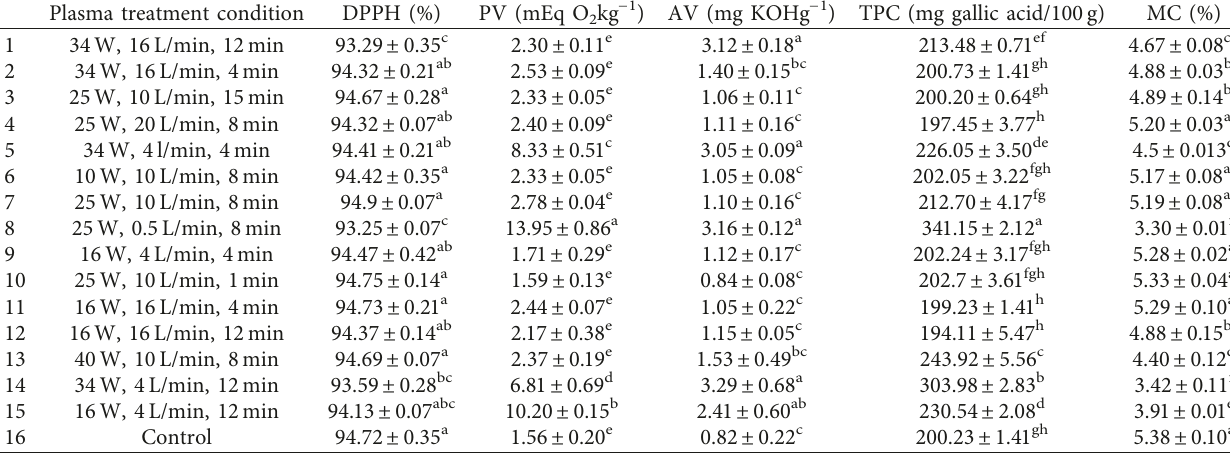
Table 2: Mean values comparison of chemical and antioxidant properties of cold plasma-treated peanut ( p < 0 . 05). Plasma treatment